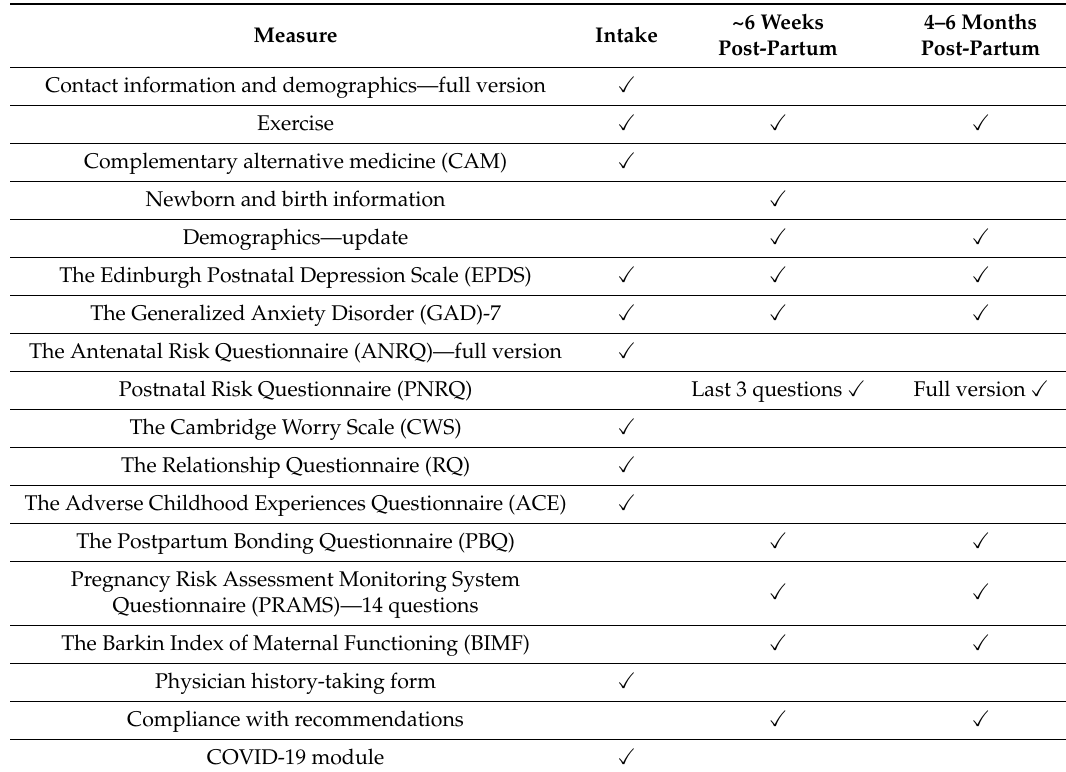
Table 2. Timeline of protocol 1 (first seen during pregnancy).